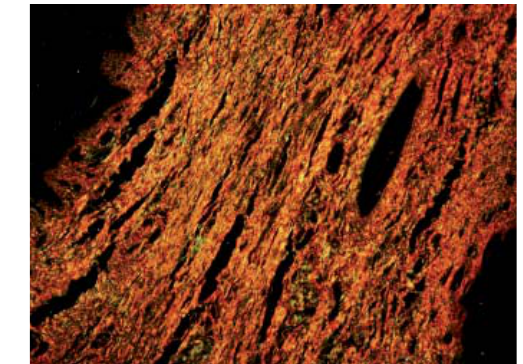
Figure 3 - Qualitative analysis of the collagen: A) Photomicrography of the prepuce of a 4 year old patient without treatment with topical steroid. Collagen type I - red; Collagen type III - green. Picro-Sirius Red stain reduced X 400. B) Photomicro- graphy of the prepuce of a 4 year old patient of the group submitted to topical steroid treatment. It is possible to observe an enlargement of green color (collagen type III), in this group. Picro-Sirius Red stain reduced X 400.